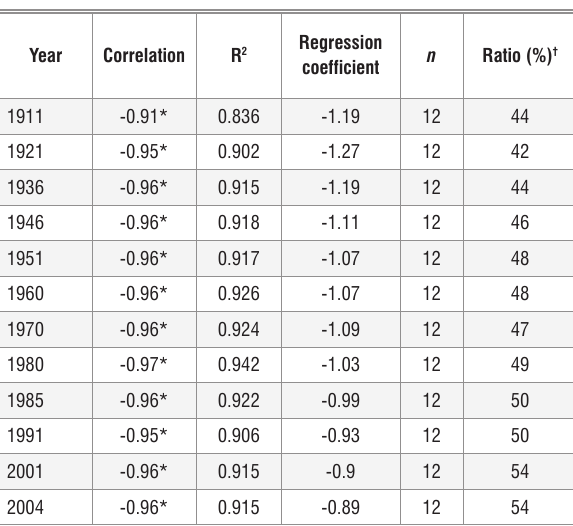
values against log 10 10